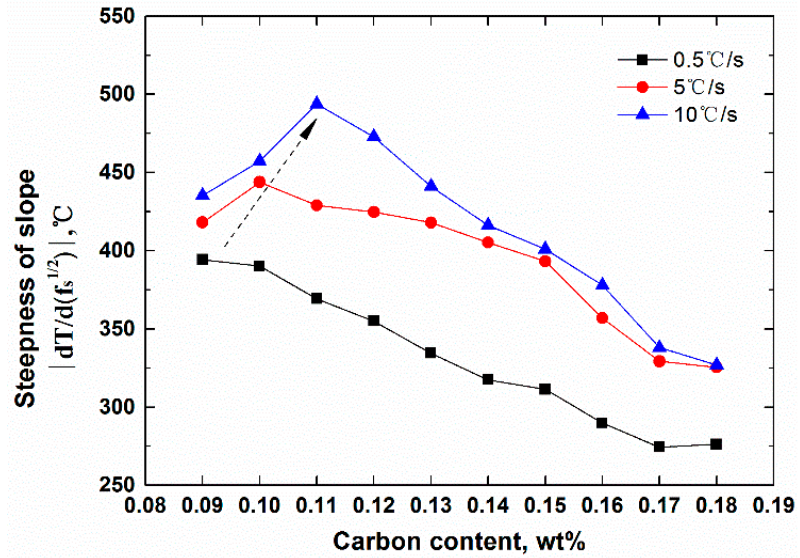
Figure 4. Calculation of | d T / d( f s ) 1 / 2 | of peritectic steels under three cooling rates: 0.5, 5, 10 ◦ C /s.